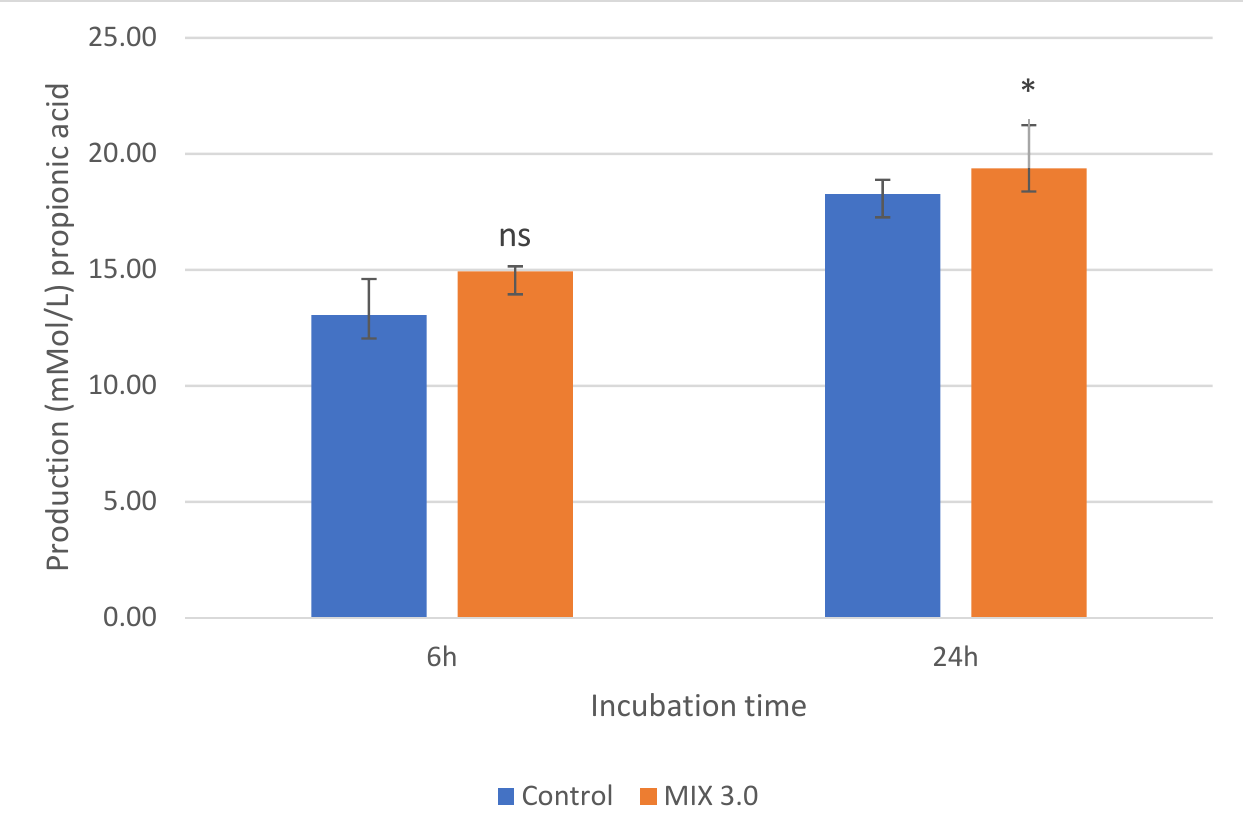
Figure 1. Comparison of production of propionic acid after 6 h and 24 h of incubation of ruminal fluid with and without